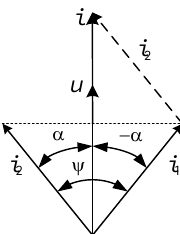
Fig. 1. Vector diagram of the input currents of equivalent 12-pulse rectifier with electronic phase shifting. The angles of the control are  =  /2. The input current I of